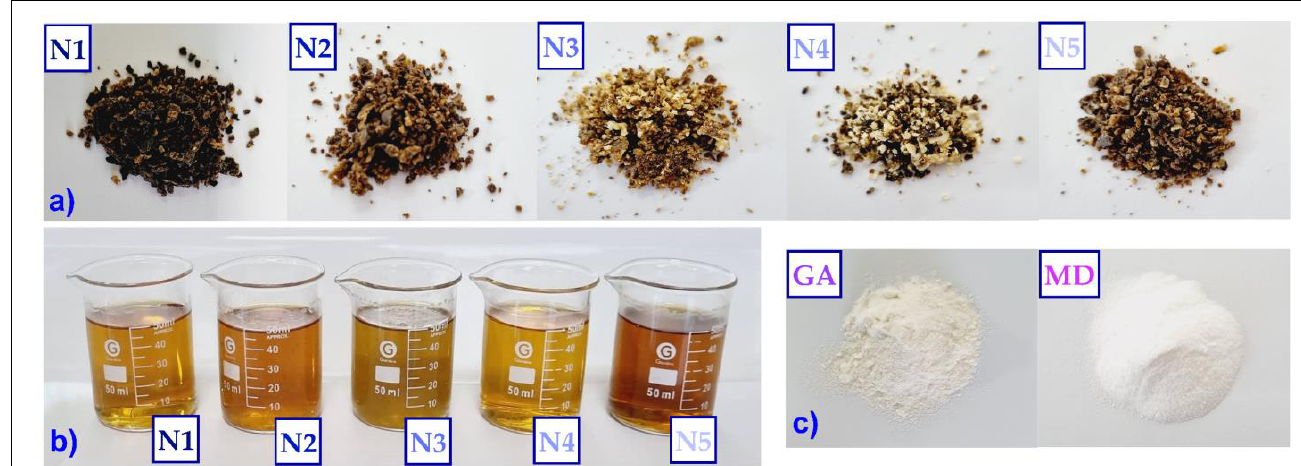
Figure 2. Raw materials and extracts; ( a ) crude propolis (N1, N2, N3, N4, and N5), ( b ) ethanolic extracts propolis (N1, N2, N3, N4, and N5), and ( c ) wall materials, gum arabic (GA) and maltodextrin (MD).